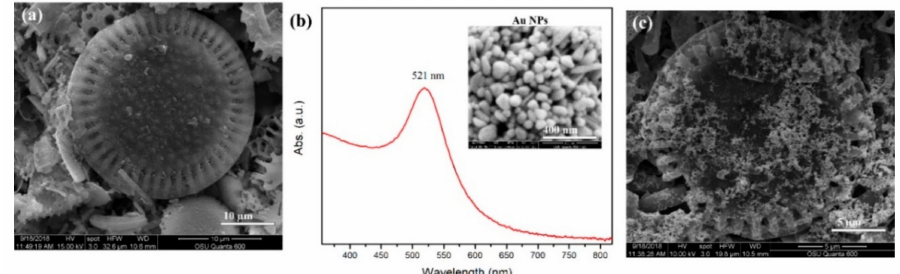
Figure 2. ( a ) The FE-SEM top-view image of diatomaceous particles. ( b ) The SPR spectra of as-prepared Au NPs with an inset FE-SEM image of Au NPs, and ( c ) the FE-SEM top-view image of Au NPs on the diatomaceous particle.